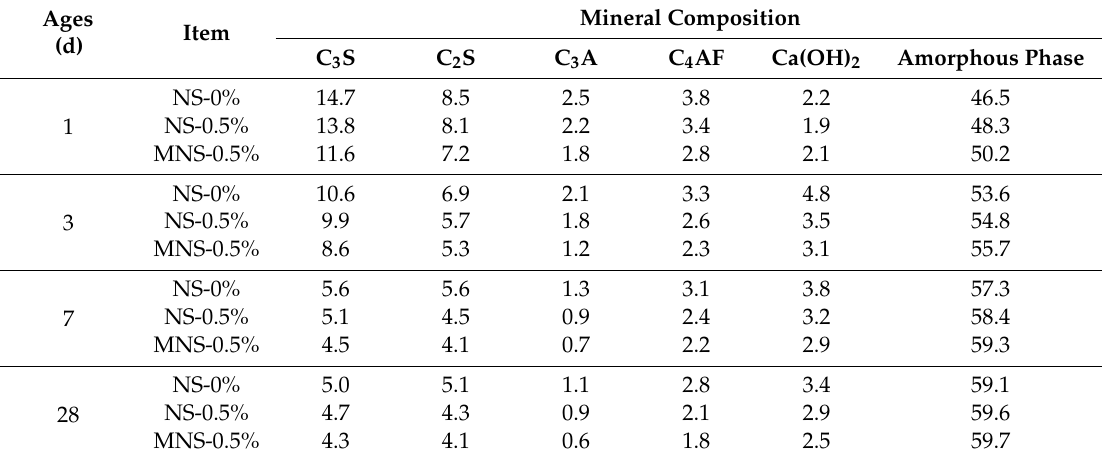
Table 5. Quantitative analysis results of HPC at di ff erent curing times